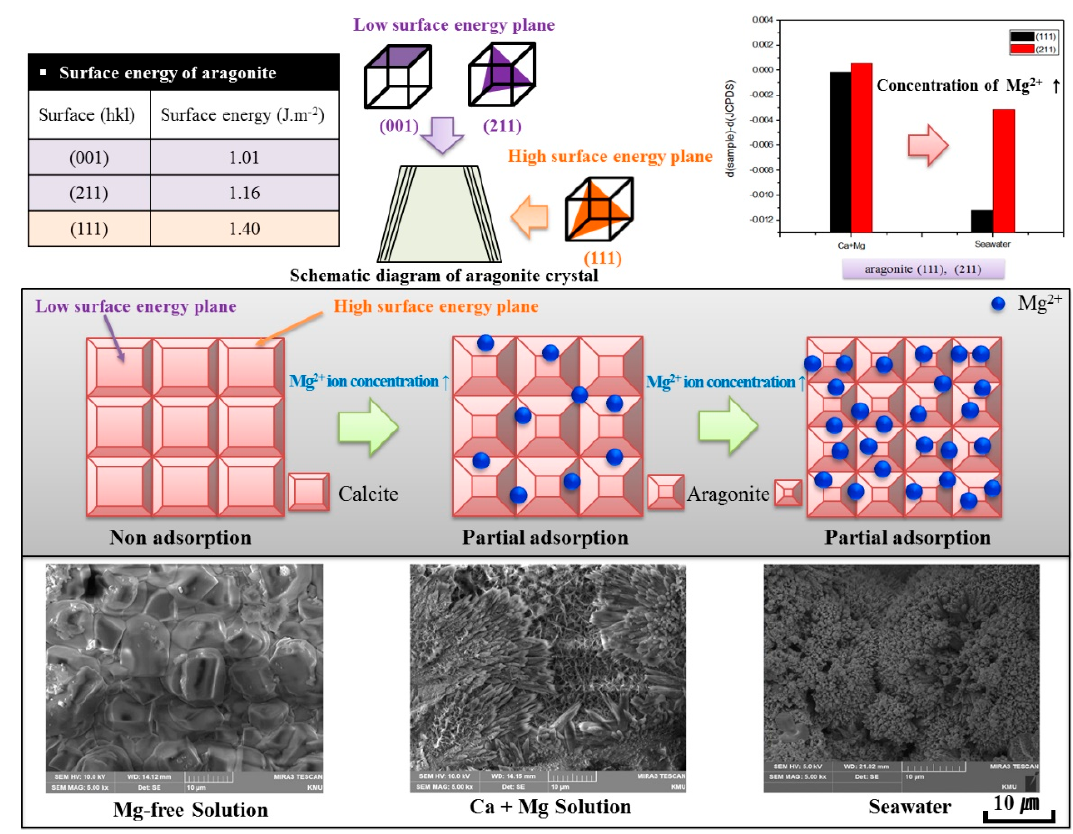
Figure 9. Schematic diagram of mechanism for changing of crystal structure in CaCO 3 films by inhibition effect.